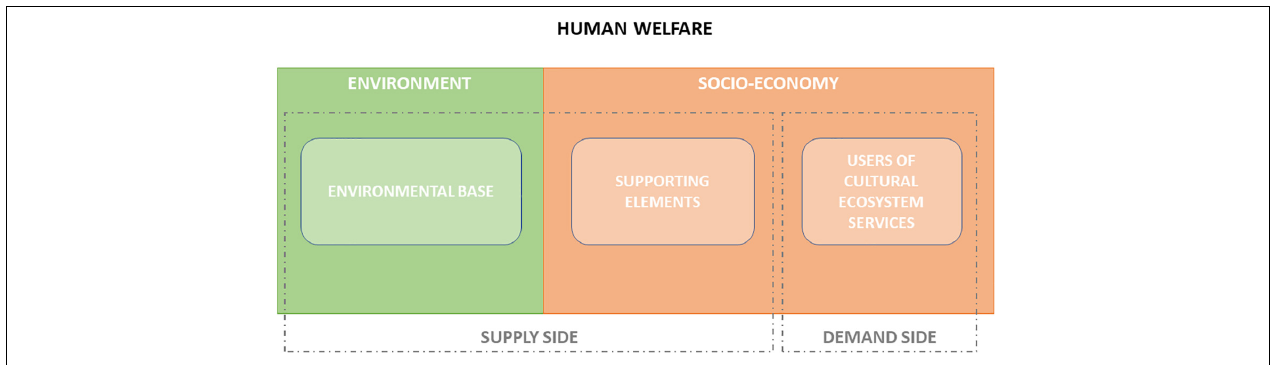
FIGURE 2 | Supply and demand sides of cultural ecosystem services. To obtain human welfare, [W in DAPSI(W)R(M)], the environmental elements (i.e., ecosystem services) need to interact with supporting elements (i.e., infrastructure) and cultural ecosystem services’ users (recreationalists). Adapted from Kulczyk et al. (2018).